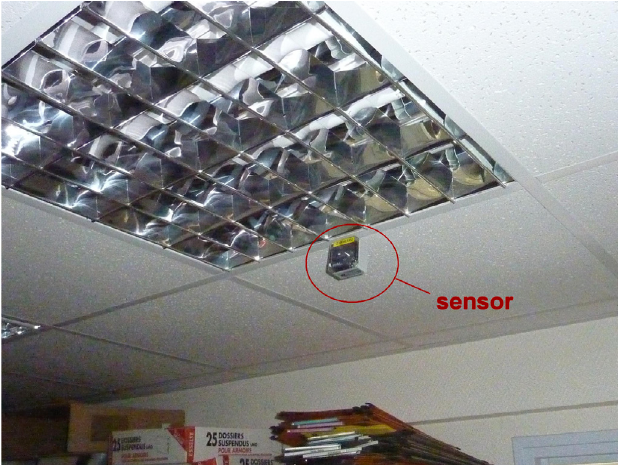
Fig. 9. Example of position of a light sensor for lighting detection.